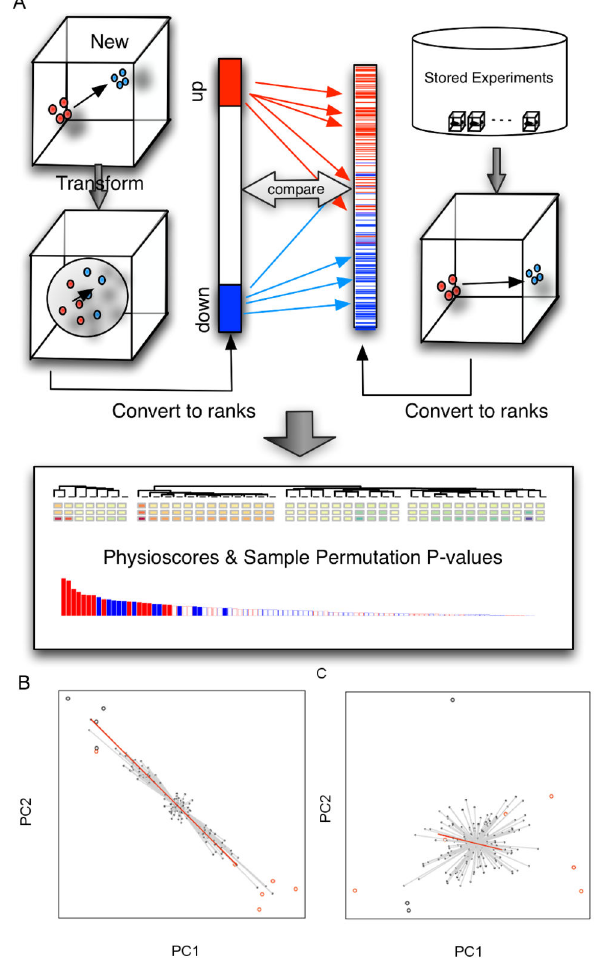
Figure 2. Overview over the PhysioSpace algorithm.